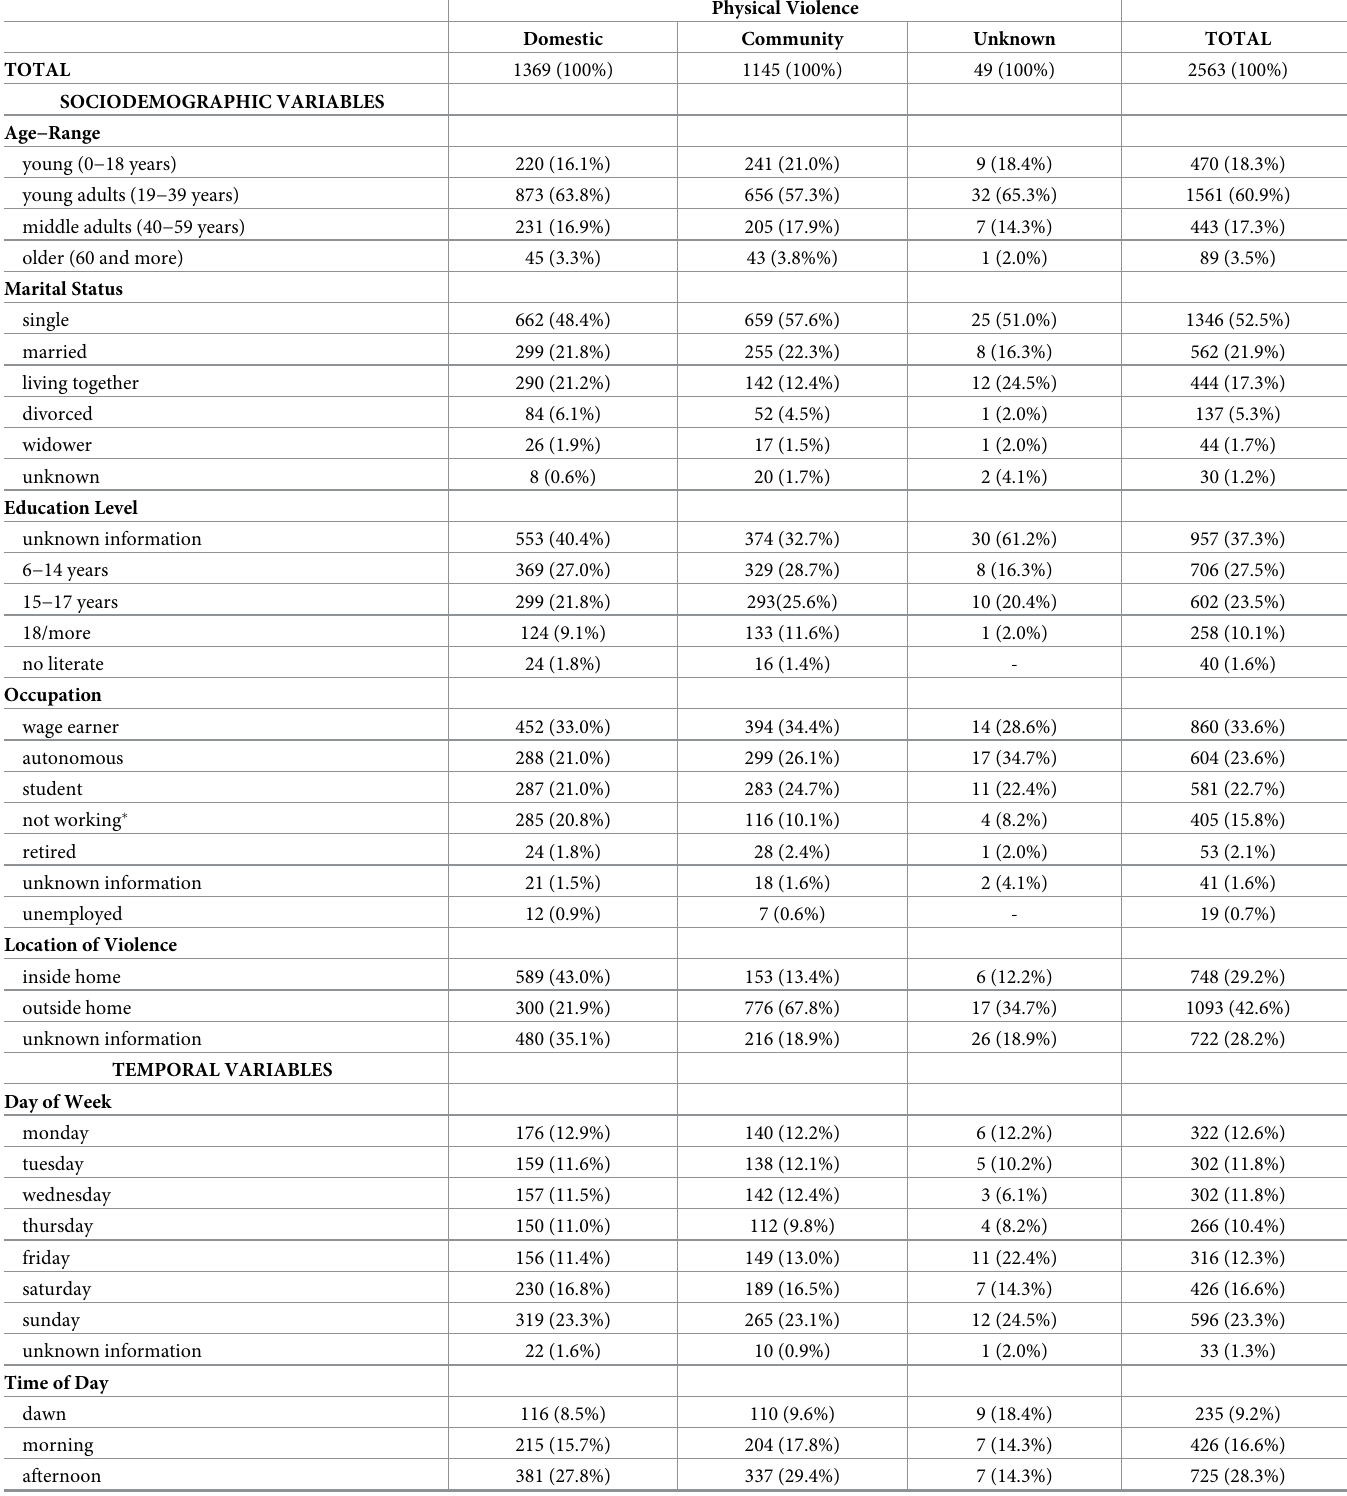
Table 1. Sociodemographic, temporal and incident characteristics among victims of violence. All 2563 cases for Campina Grande urban area, 2012 −